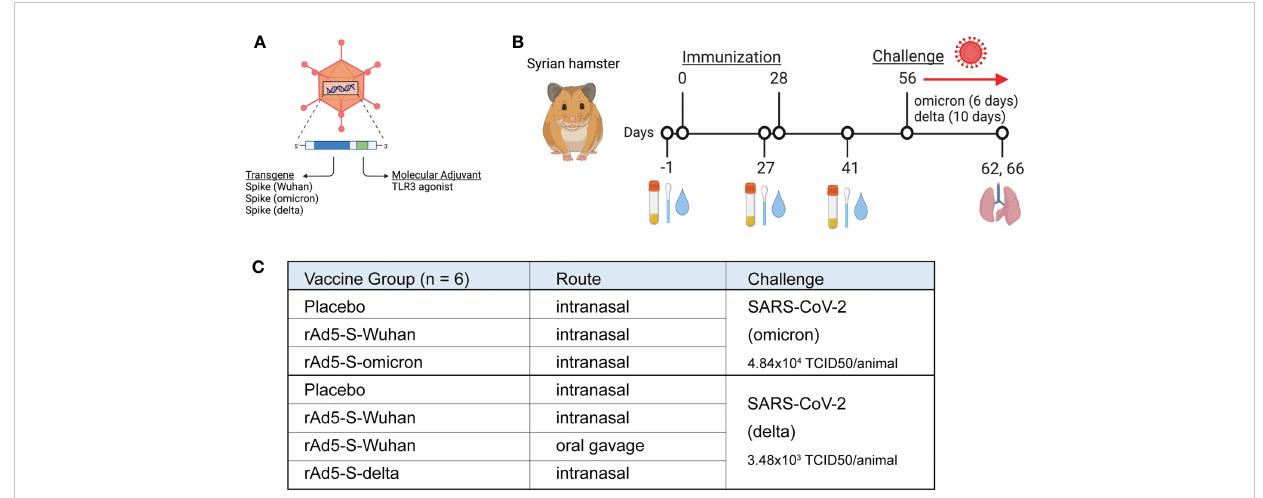
FIGURE 1 Study design for immunogenicity and ef fi cacy of rAd5 vaccines against SARS-CoV-2 variants of concern. (A) Illustration of the rAd5 vector used in vaccination with the transgene (spike) and molecular adjuvant. (B) Schedule of vaccination, sample collection, and viral challenge. (C) Vaccination groups and administration routes in preparation for viral challenge. Figure was made with